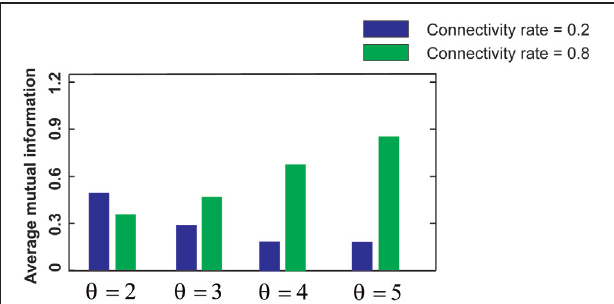
FIGURE 4 | Mutual information for low and high connectivity rates. The average mutual information for a low connectivity rate equal to 0.2 is decreased by increasing firing threshold while it is increased for high connectivity rate equal to 0.8.